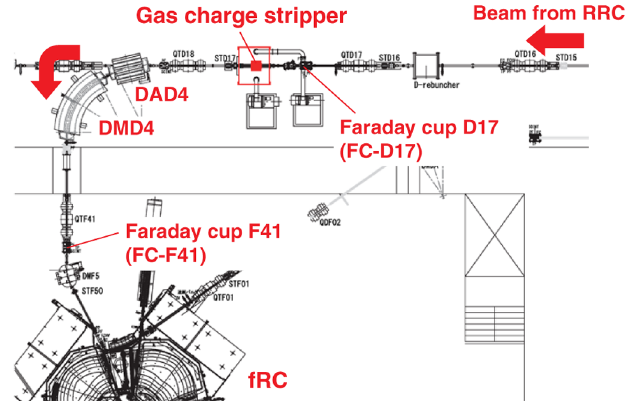
FIG. 2. Schematic view of the beam line around the gas charge stripper. The beam intensity upstream of the gas charge stripper was measured using a Faraday cup (FC-D17). Stripped beams were analyzed using a pair of dipole magnets DAD4 and DMD4. The beam intensity downstream of DAD4 and DMD4 was measured using a Faraday cup (FC-F41).